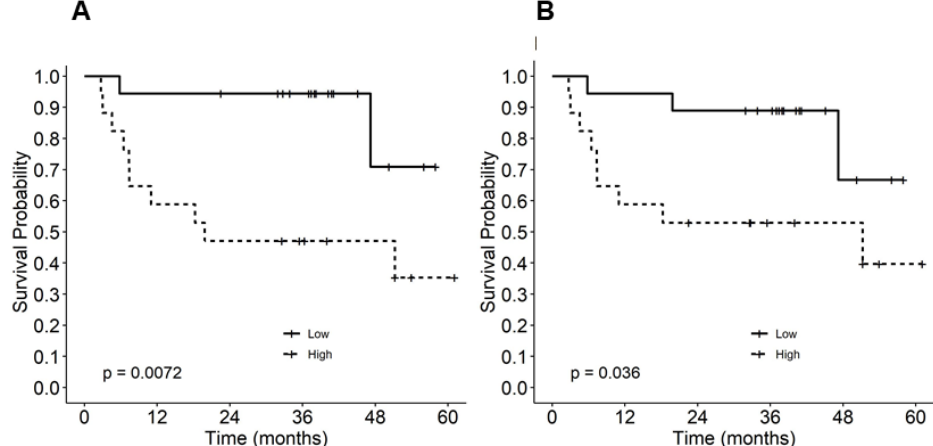
Figure 2. Kaplan–Meier relapse-free survival estimates by phosphorylated STAT1 (pSTAT1) level ( A ) before and ( B ) after ipilimumab treatment.